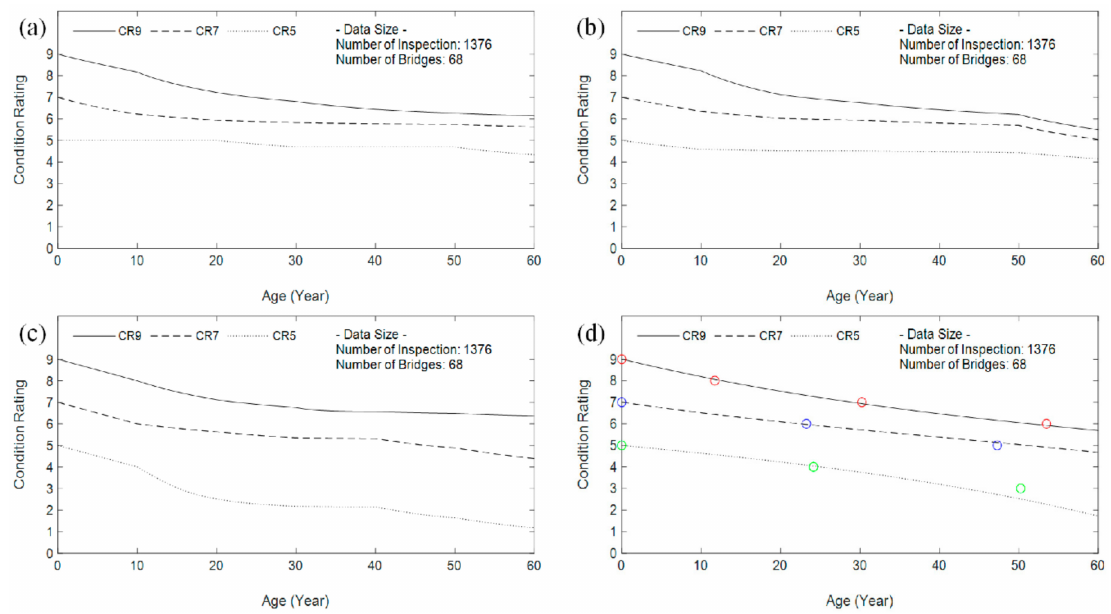
Figure 11. Superstructure deterioration models for a subset of Wyoming bridges associated with “DST 1” (cast-in-place concrete), “BRW 4” (range between 4 and 6 m), and “DL 5” (MS 18), using ( a ) percentage prediction, ( b ) logistic regression, ( c ) optimization, ( d ) Weibull